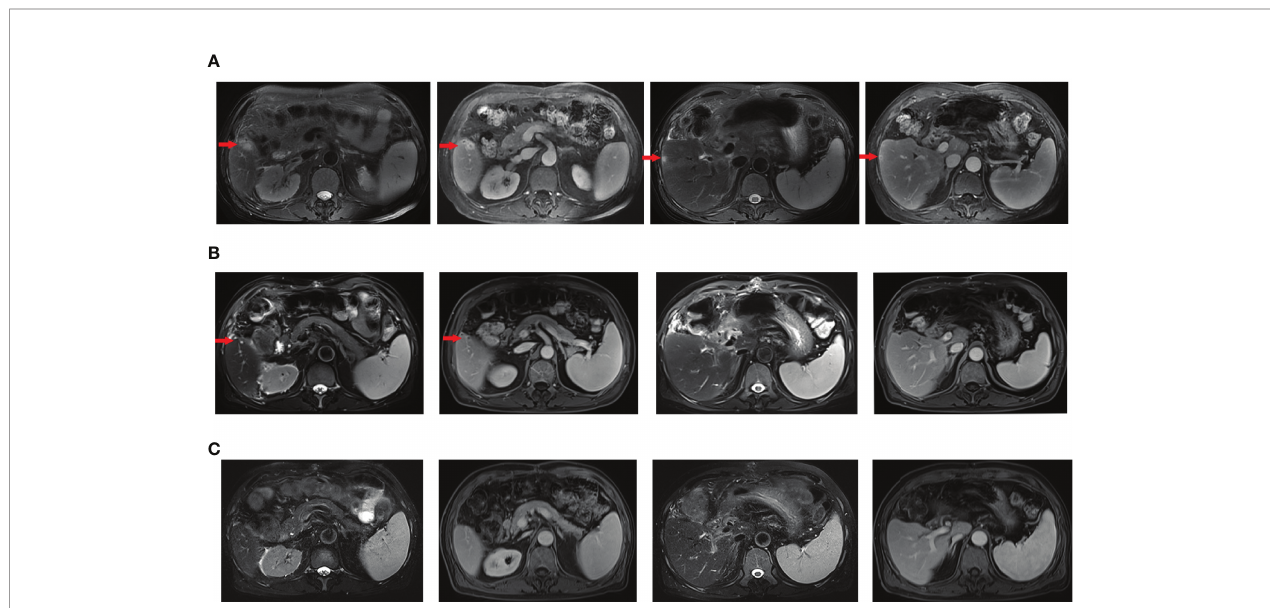
FIGURE 1 | Enhanced abdominal magnetic renounce imaging (MRI) of the reported case. (A) T2-weighted and arterial phase images of liver metastasis before camrelizumab combined with apatinib (November 6, 2020). The red arrows direct to the recurrent lesions in the liver. (B) MRI showed a partial response in liver metastasis from T2-weighted and arterial phase images after 2 cycles of combination therapy (December 22, 2020). The mass (arrow) adjacent to the surgical zone decreased to 0.6 cm in the maximum diameter (1.1 cm before treatment). The lesion under the liver capsule of S5 disappeared. (C) MRI showed that lesions in the liver completely disappeared after 4 cycles of combination therapy (February 1,